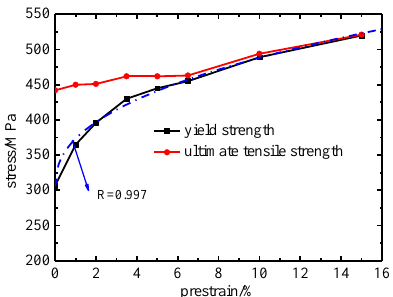
Figure 6. Variation of strength parameters.